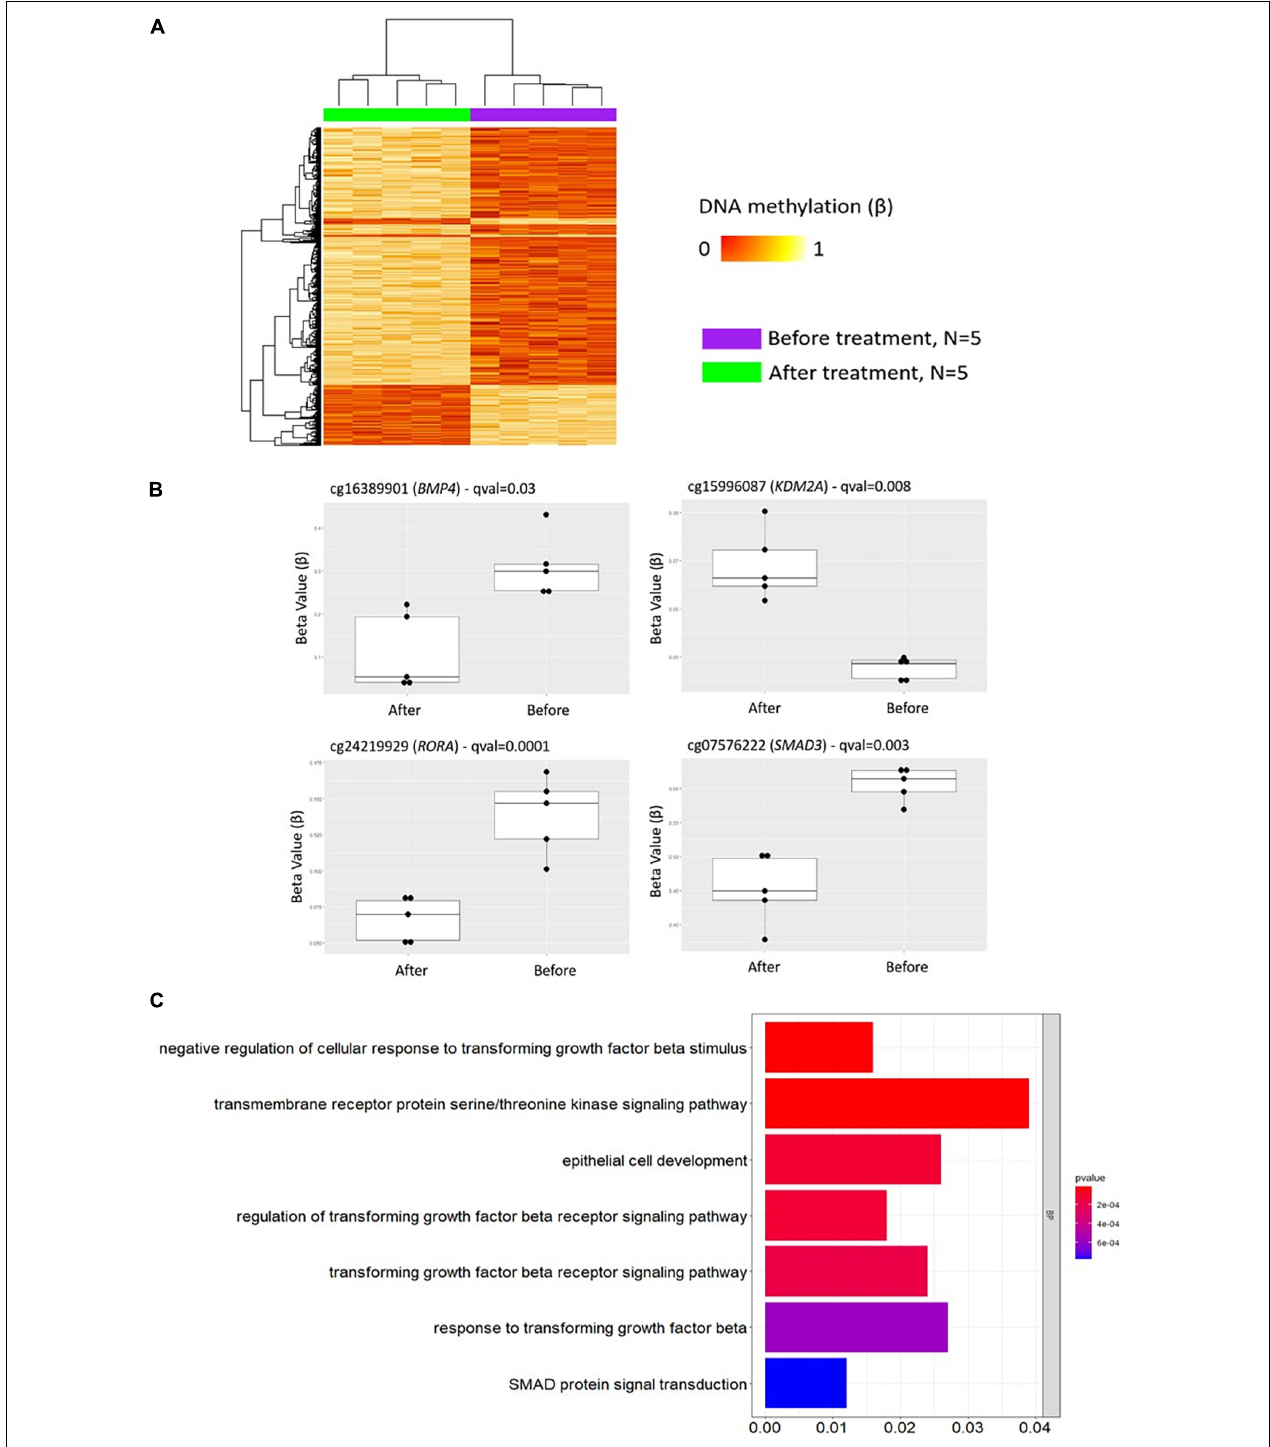
FIGURE 5 | DNA methylation profiles in CD8 + T cells from patients with psoriasis change in response to treatment. (A) Heat map showing differentially methylated positions (DMP) in CD8 + T cells from psoriasis ( N = 4 psoriasis and N = 1 psoriatic arthritis) before and after treatment (FDR < 0.05, | (cid:49) β | > 0.1) with TNF inhibitors or inactivating IL-17A antibodies. Normalized DNA methylation levels are shown on the right red indicating reduced methylation and yellow indicating increased methylation levels. (B) Differences in beta values of selected CpG sites identified as DMP comparing status “before” versus “after” treatment initiation. (C) The bar plot shows the results of the Gene Ontology (GO) analysis of genes which presented at least on DMP in their promoter. Only significantly enriched terms for Biological process (BP) are represented ( P < 0.05).